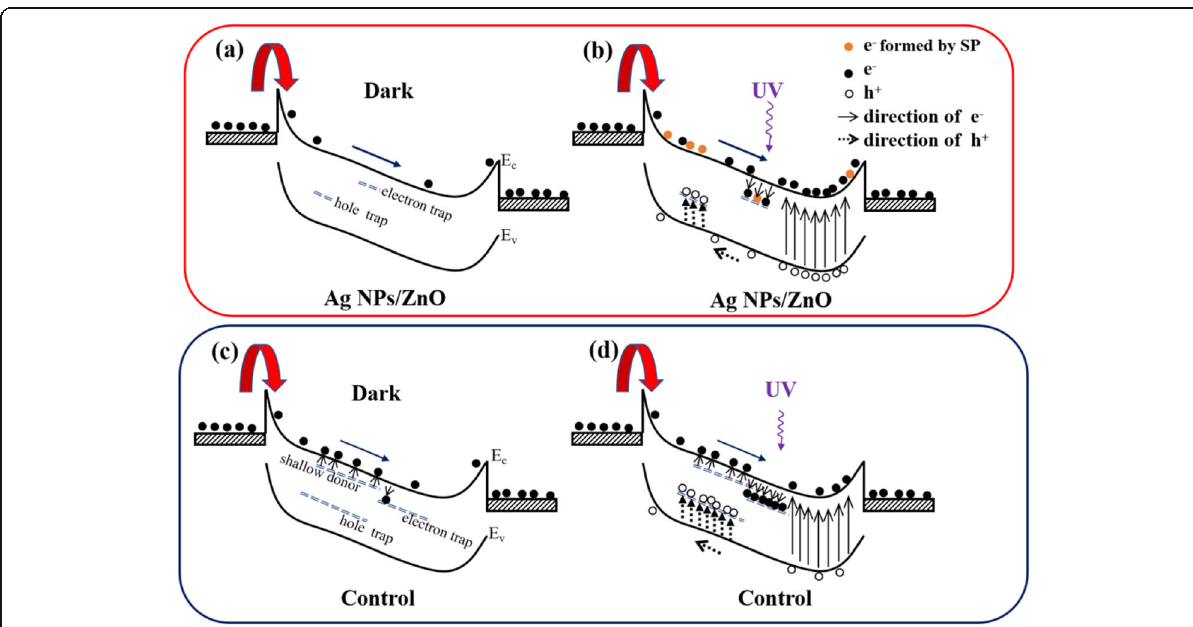
Fig. 5 a , b Schematic diagram for carrier transportation and generation of ZnO film with Ag NPs in dark and in 365 nm illumination, respectively. c , d Schematic diagram for carrier transportation and generation of ZnO film without Ag NPs in dark and in 365 nm illumination respectively. Liu et al.